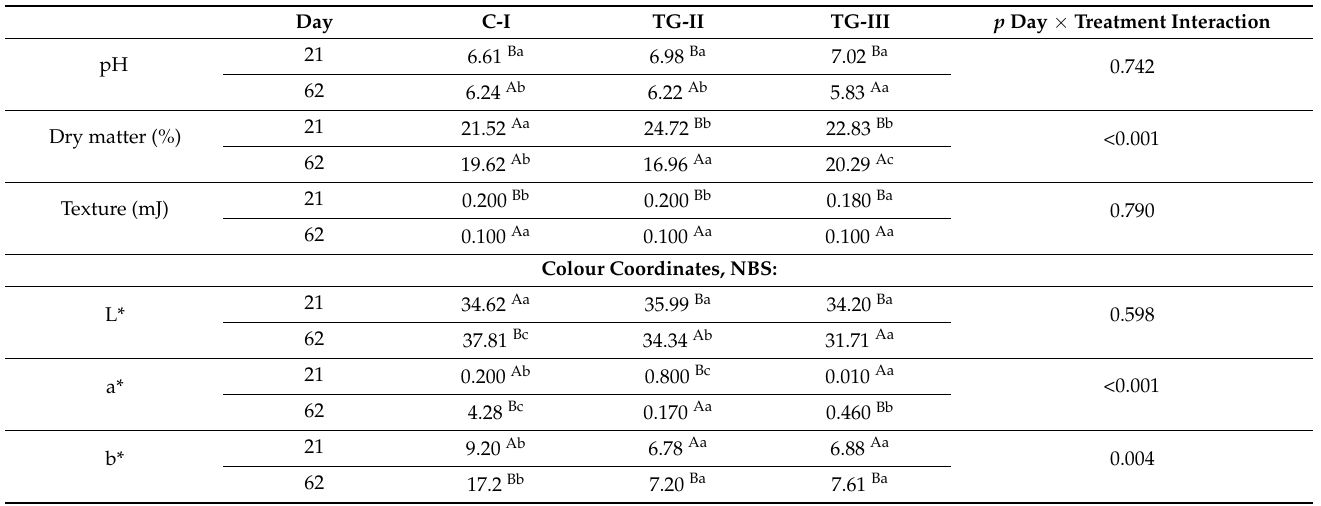
Table 6. The pH, dry matter, and colour coordinates of the piglets’